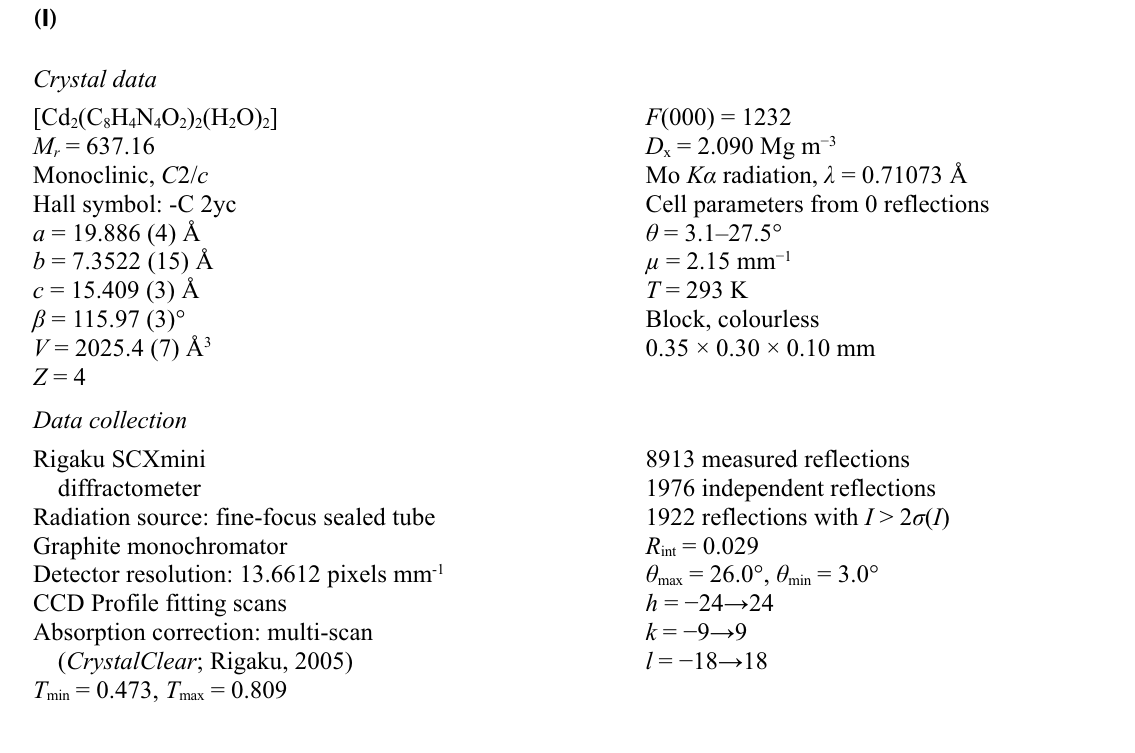
Packing diagram of the title compound, showing the structure along the b axis. No displacement parameters are displayed and H atoms have been omitted for